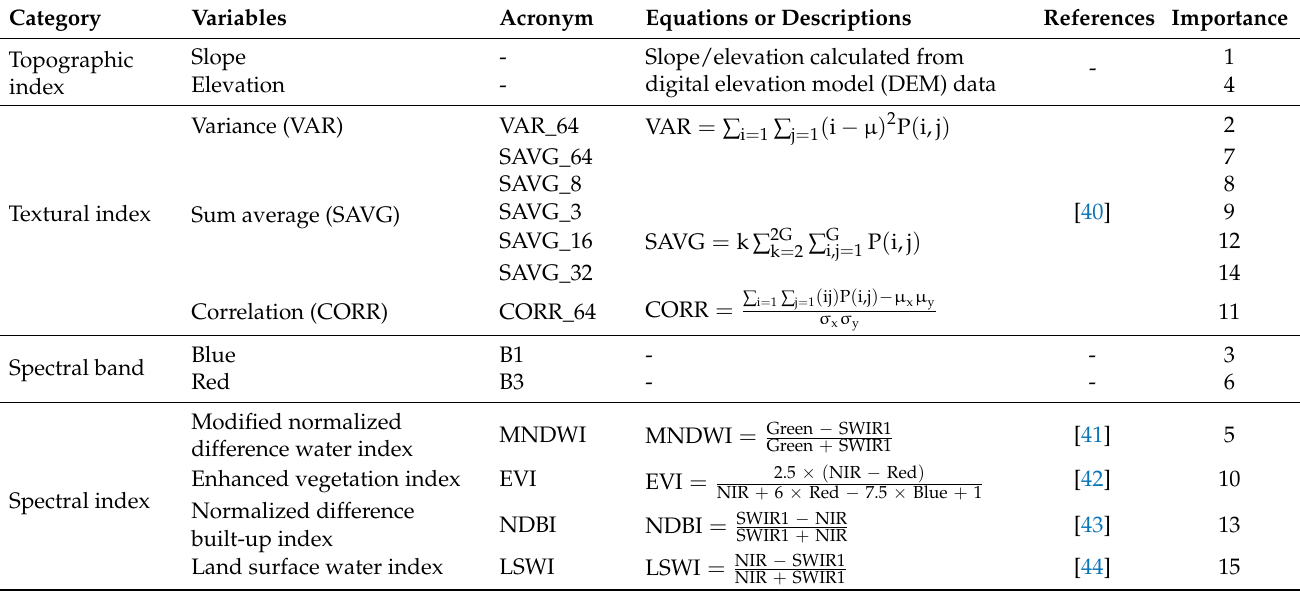
Table 1. Top 15 variables ordered by their importance in the land-cover